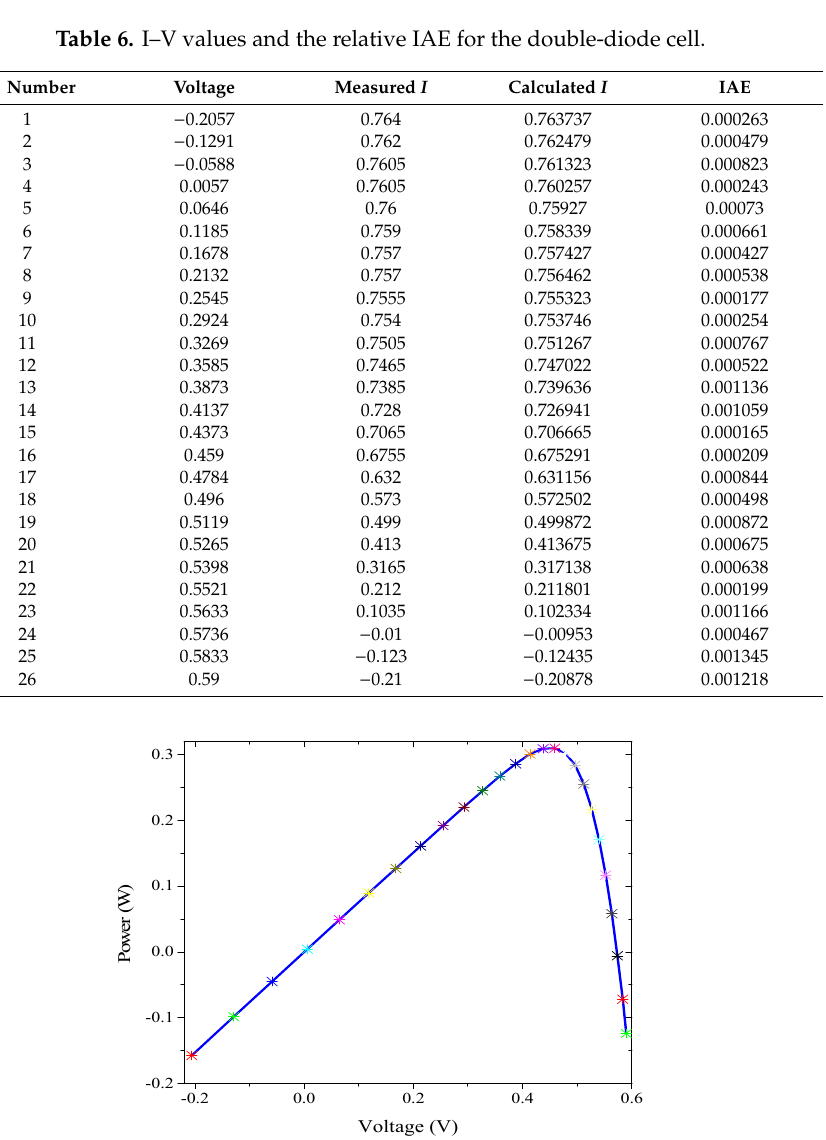
Figure 9. P–V curve obtained from the calculated current for the double-diode cell.